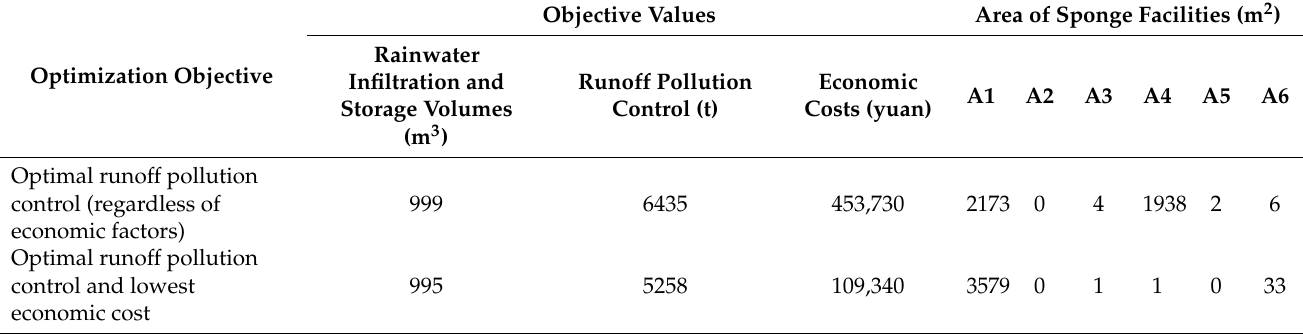
Figure 10. Optimal parameters for runoff pollution control. Table 7. The value of the model variable when the runoff pollution control objective is